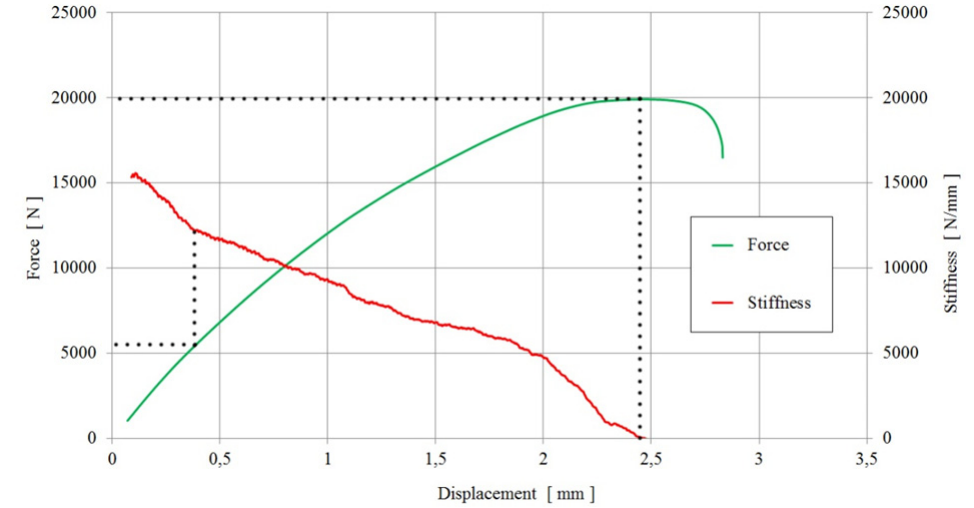
Fig. 6 Force - displacement curve of the Monel alloy 400 specimen, including its derivative.